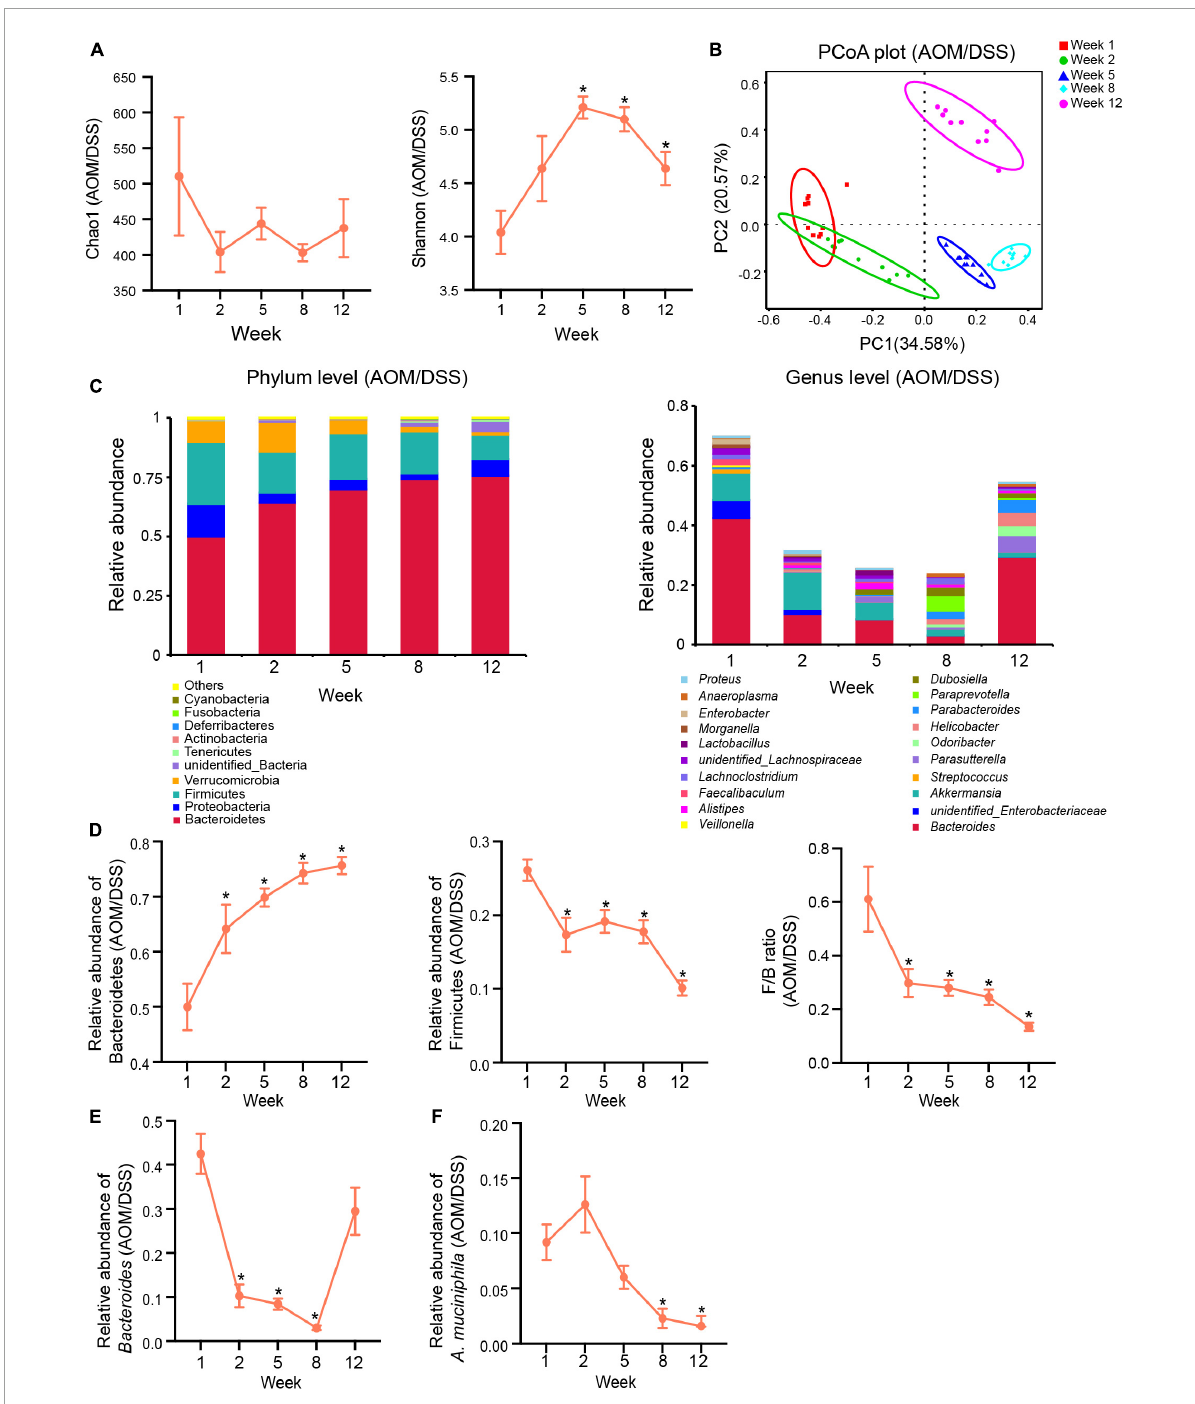
FIGURE4 Gut microbiota changed dynamically in the development of CAC in the AOM/DSS group. (A) α -Diversity indexes (Chao1 and Shannon) of the gut microbiota in different stages of tumorigenesis. (B) PCoA plot based on Bray-Curtis distance showing the dynamical composition changes in the gut microbial community during the development of CAC. (C) Relative abundance of the top ten most abundant taxa at the phylum level (left) and top twenty most abundant taxa and genera (right) during the different stages of tumorigenesis. (D) Changes in relative abundances of Bacteroidetes and Firmicutes and changes in the ratio of Firmicutes/Bacteroidetes (F/B) in the development of CAC. (E) Changes in the relative abundance of Bacteroides in the development of CAC. (F) Changes in the relative abundance of A. muciniphila in the development of CAC. Data are shown as means ± SEM. * P < 0.05. The levels of each index at different time points compared with the corresponding level of week 1. Week 1: baseline, week 2: after AOM injection, week 5: after the first cycle of DSS treatment, week 8: after the second cycle of DSS treatment, and week 12: after the third cycle of DSS treatment and before